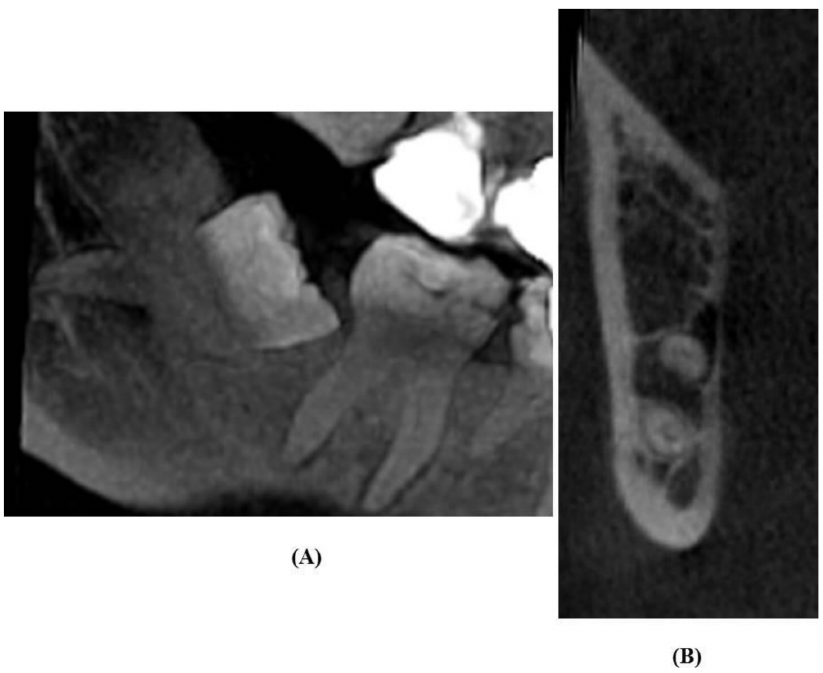
Figure 3. Panoramic images show darkening of the roots ( A ), and the inferior alveolar canal posi- tioned between the roots without cortication on CBCT images ( B ).